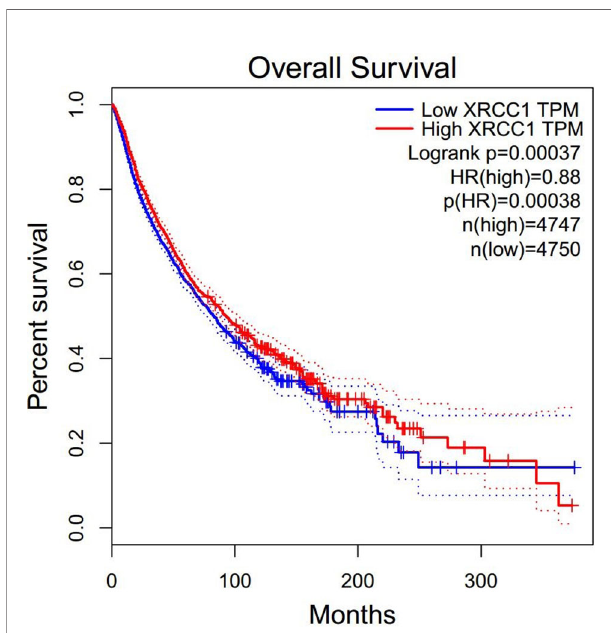
FIGURE 2 | Overall survival of XRCC1 expression in TCAG data